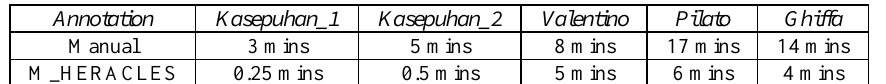
Table 2. Comparison of annotation